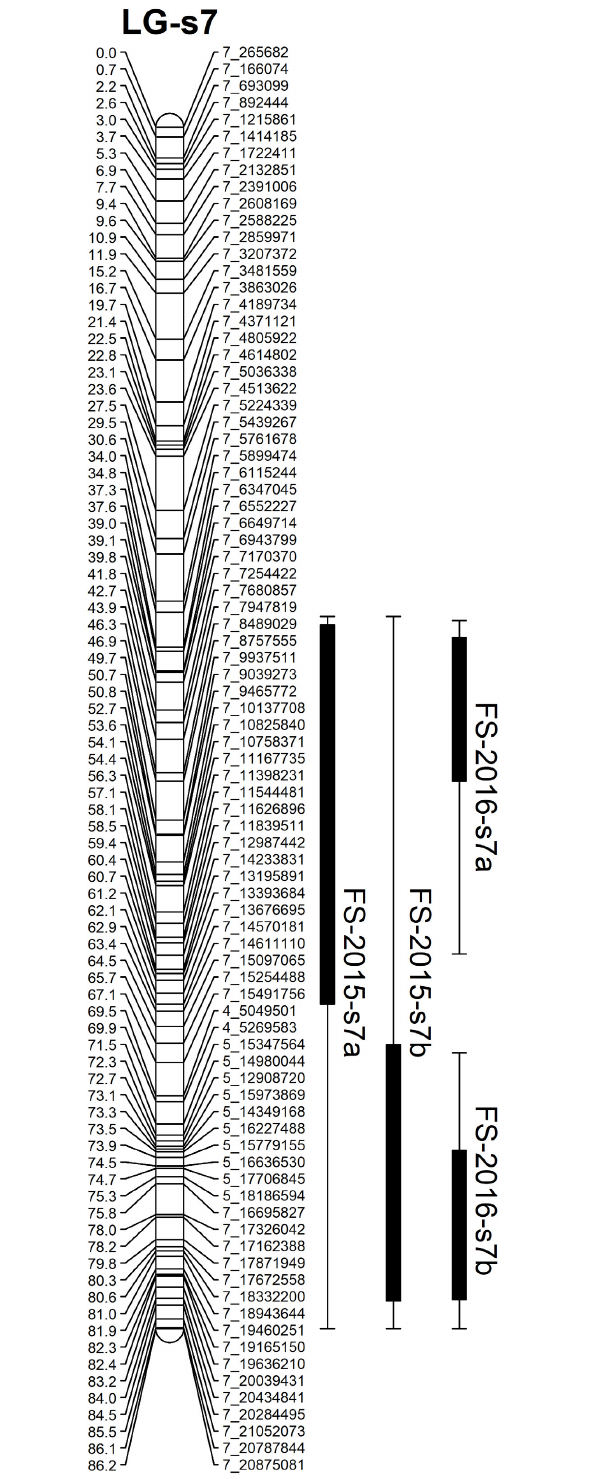
Frontiers in Plant Science |